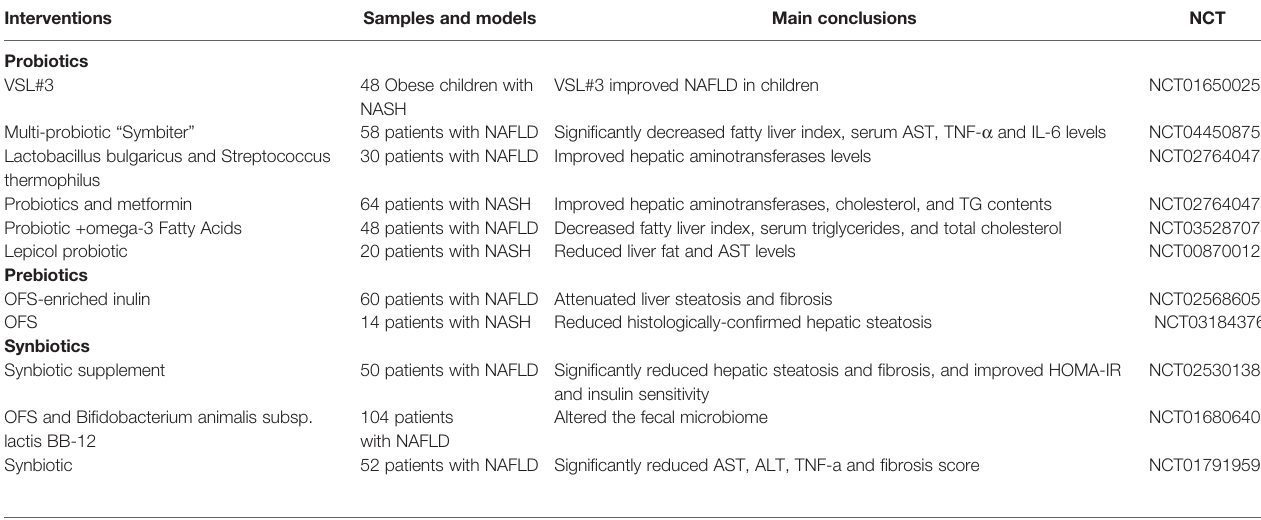
TABLE 2 | Intestinal microbiota-targeted therapies of NASH-clinical trials.